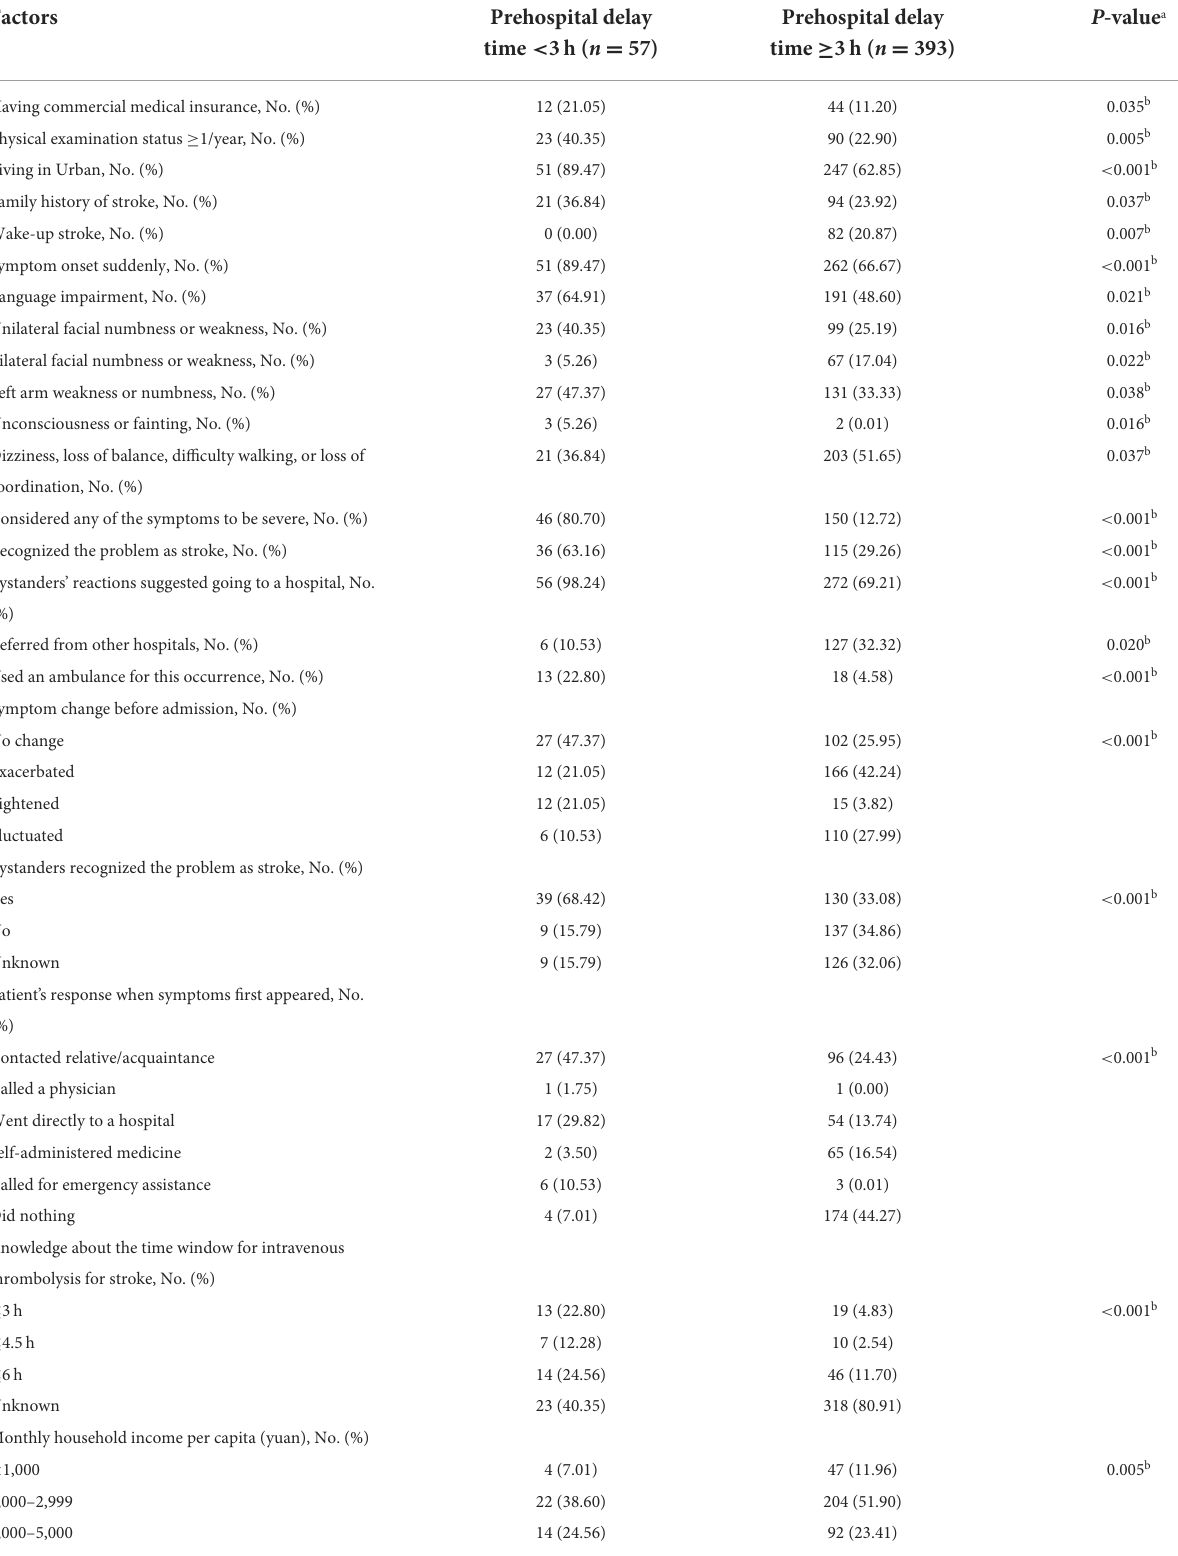
TABLE 2 Prehospital delay according to patient characteristics ( n =